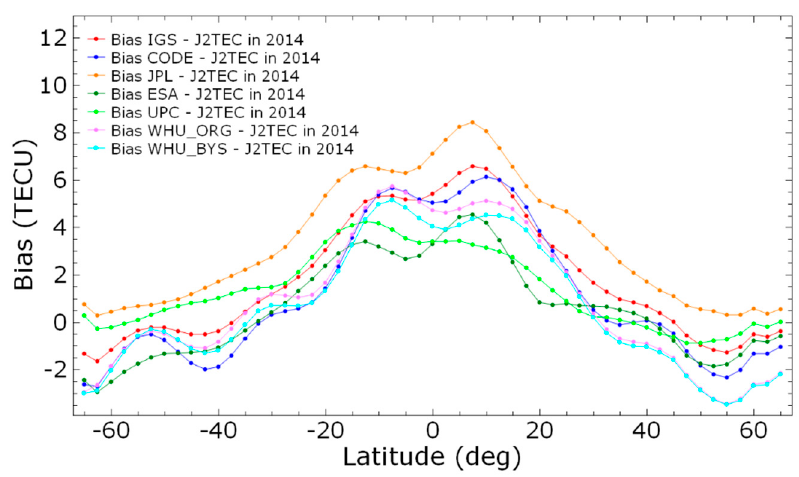
Figure A1. Bias values for comparison between IGS GIMs or IAAC products and J2TEC in 2014.